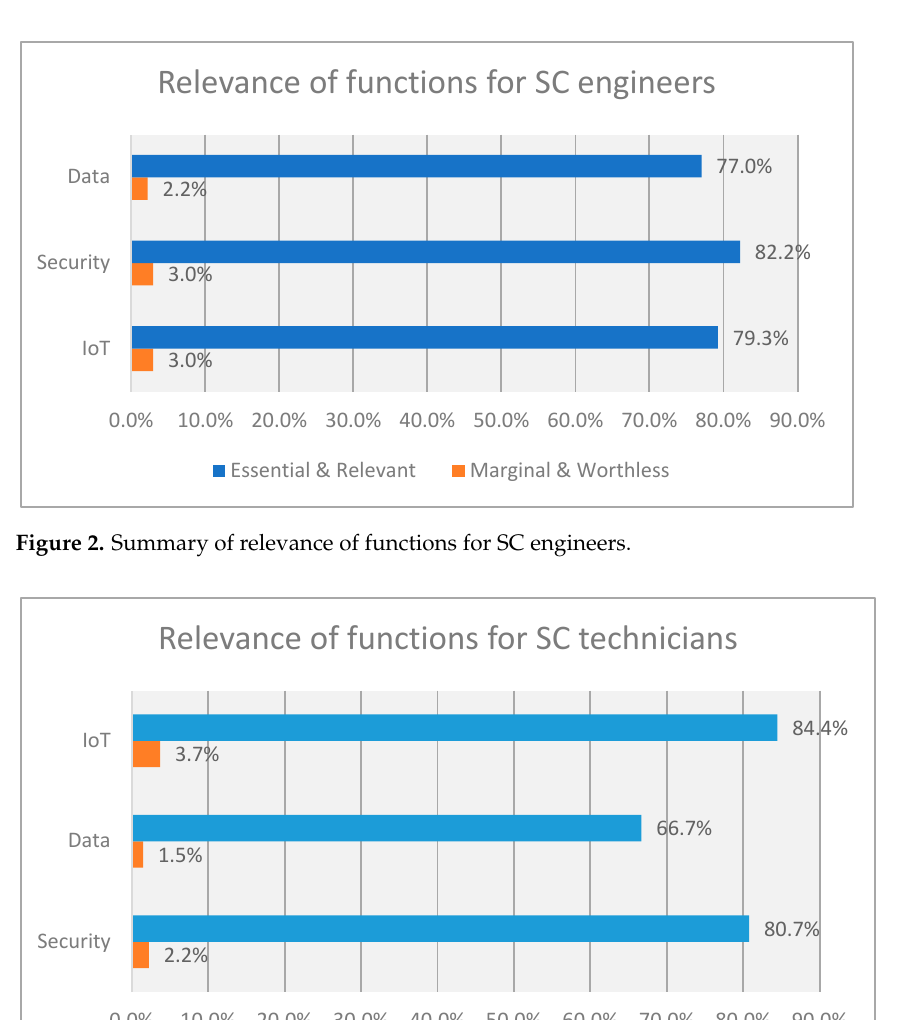
Table 4. Mapping of functions to the e-competence of EN16234.